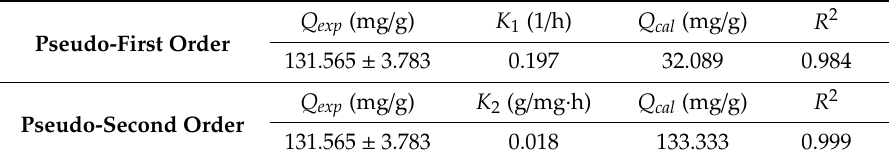
Figure 5. Adsorption isotherms plots of ( a ) Langmuir and ( b ) Freundlich; adsorption kinetics plots of ( c ) pseudo-first-order model and ( d ) pseudo-second-order model. All experiments were performed in triplicate; error bars denote standard deviation. Table 2. Pseudo-first order and pseudo-second-order kinetic